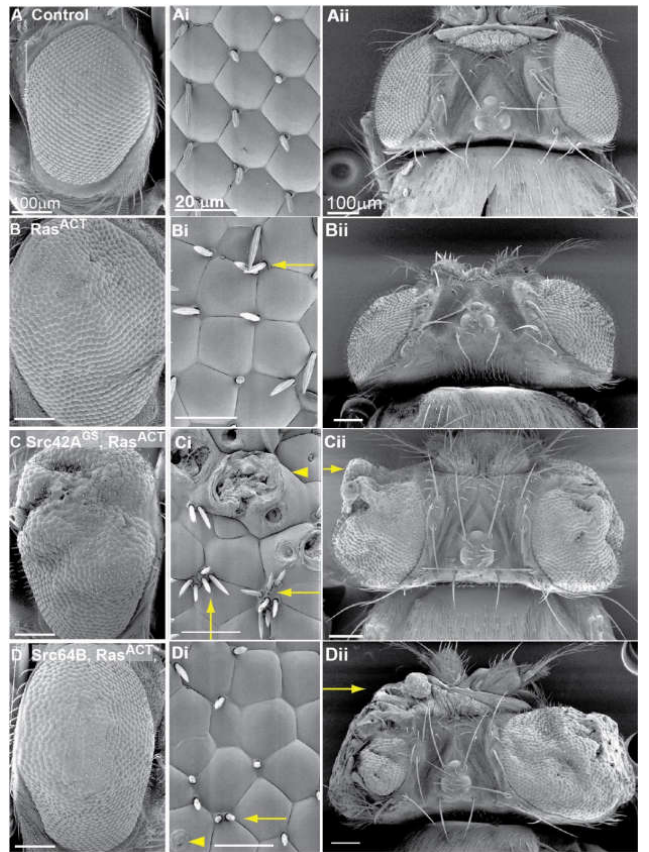
Figure 1. Src enhances hyperplastic ey > Ras ACT adult eye phenotype. Scanning electron micrographs